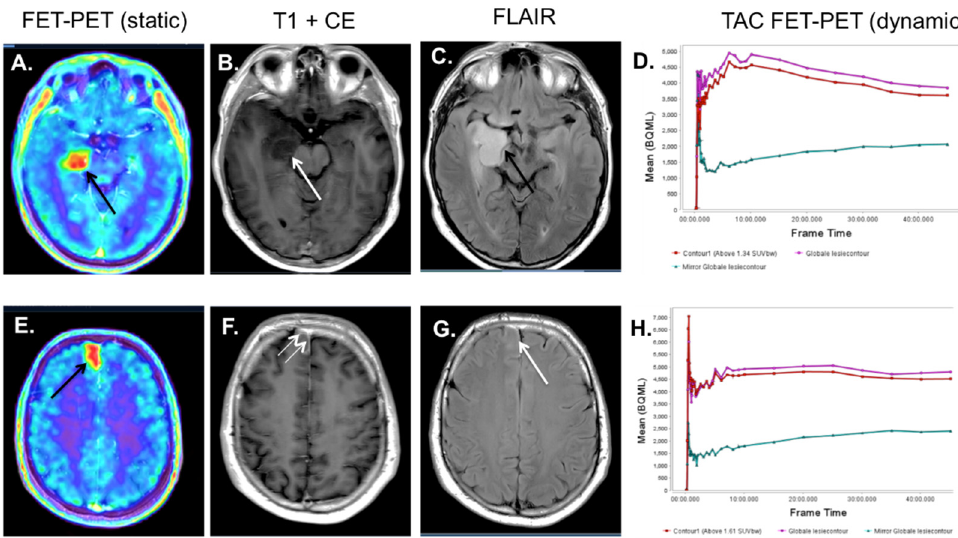
Figure 1. Patient presenting with an epileptic seizure. Initially, based on the MRI, the patient was suspected to have a LGG, as there was a lack of contrast enhancement. However, in the work ‐ up, a 18 F ‐ FET ‐ PET ‐ MRI was acquired. The PET ‐ MRI shows a glial tumor in the right mesial temporal lobe on the FLAIR (black arrow, ( C )), without contrast enhancement, with an intense tracer accumulation centrally in the lesion (black arrow, ( A )). ( B ) shows the MRI T1 after contrast administration, showing no enhencement at the site of the leasion (white arrow). On the TAC of the dynamic 18 F ‐ FET ‐ PET ( D ), a descending curve is visible in red/purple, making the lesion more suspicious of an HGG. At biopsy, an astrocytoma WHO grade III was found, IDH ‐ wt, without MGMT promotor methylation or 1p/19q co ‐ deletion. On the 18F ‐ FET ‐ PET ‐ MRI, a second lesion was identified in the right frontal lobe, with increased tracer uptake (black arrow, ( E )). Initially, this was missed on the MRI. Here, subtle contrast enhancement of the meninges is visible (white arrows, ( F )), accompanied by a slightly increased signal intensity on the FLAIR (white arrow, ( G )). The lesion shows a plateau on the TAC (red/purple), with a gradual decrease at the end of the curve ( H ). At biopsy, a astrocytoma WHO grade III was found.